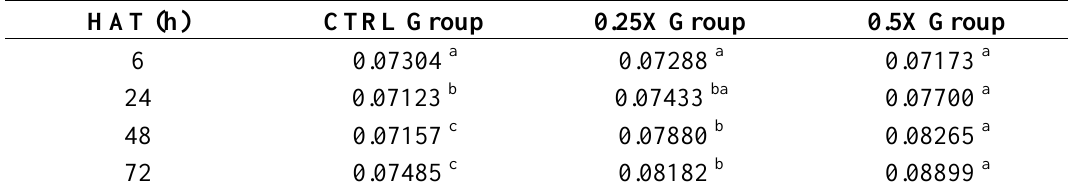
Table 6. FCA calculated for experimental soybean leaves of the three groups at 6, 24, 48, s 72 HAT. Each value is a mean of six leaves for the same group. The statistics are analyzed by Duncan’s multiple range tests.